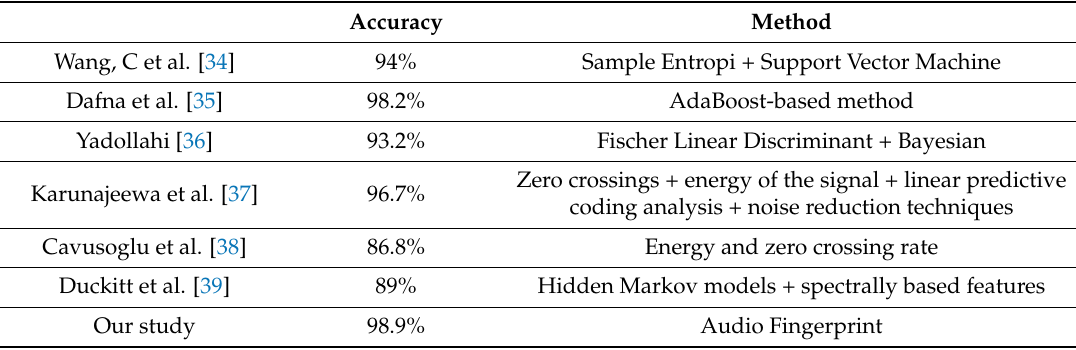
Table 4. Method comparison using snoring